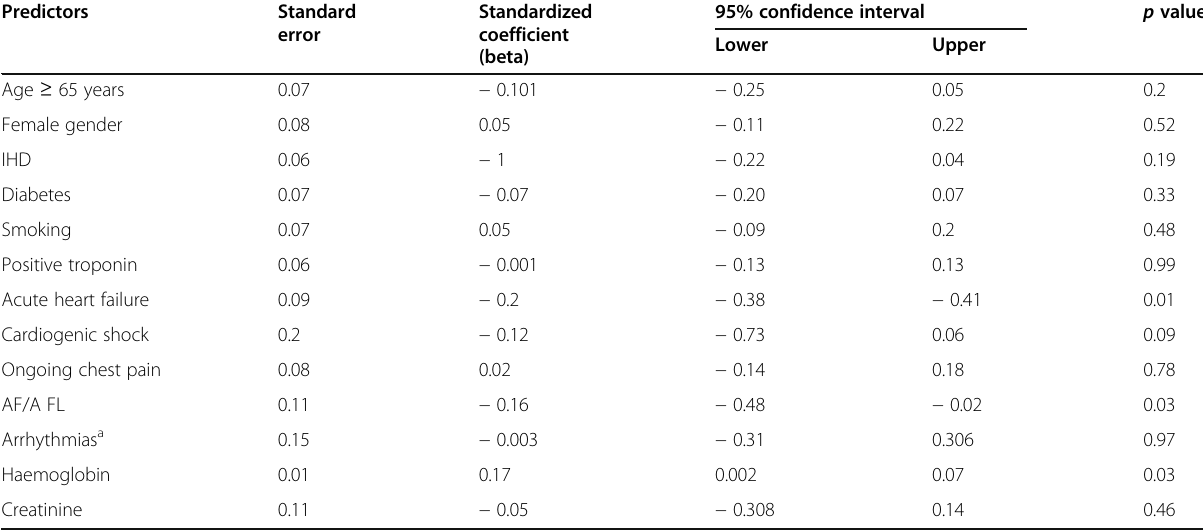
Table 4 Multi-regression analysis of predictors of invasive strategy in NSTE-ACS * Predictors